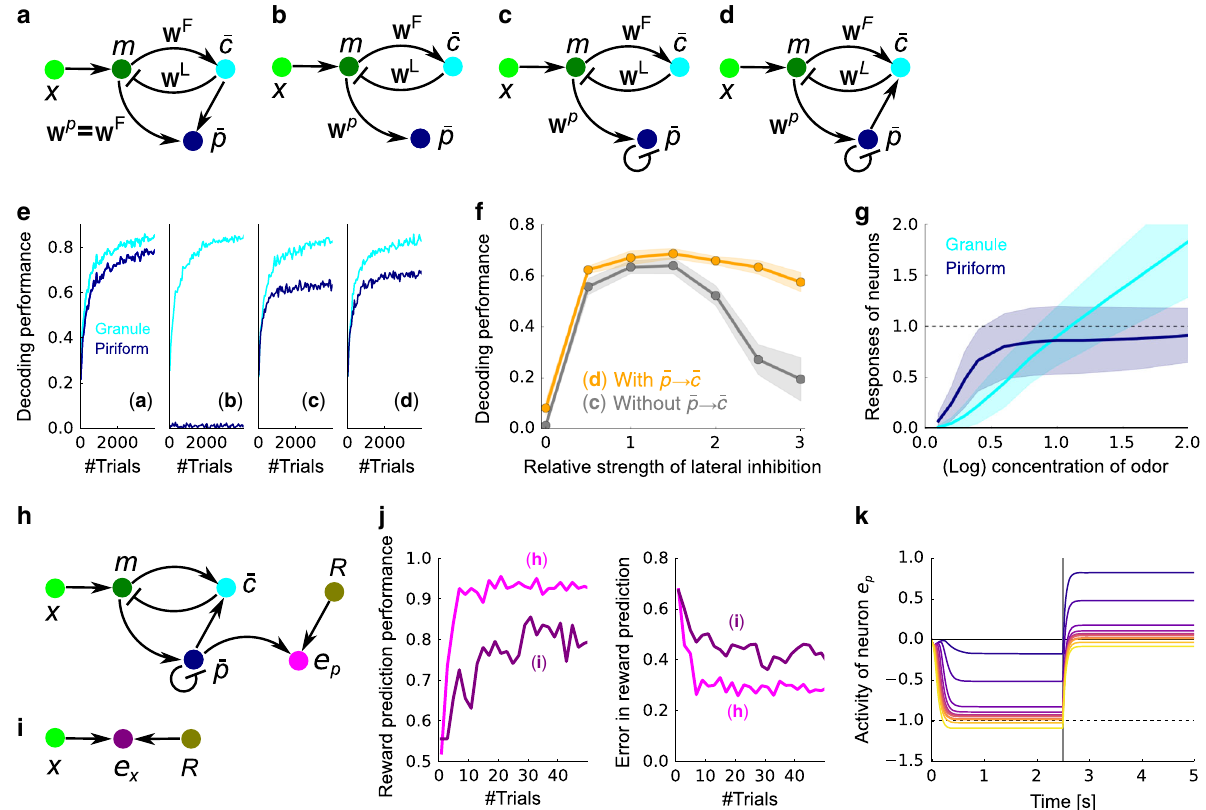
Fig. 7 Learning a concentration invariant representation and an odor-reward association. a – d A set of increasingly realistic decoding models. a The decoding model associated with our variational Bayesian inference algorithm. Note that the weights need to be copied from w F to w p , something that is not biologically plausible. b Similar circuit, but with the mapping from m to p learned via a local rule. c Same as b , but with lateral inhibition. d Same as c , but with feedback to the granule cells. e Learning performance for the models in a – d when decoding from granule cells (cyan) or piriform cortex (dark blue; see subsection “ Odor estimation performance ” in the “ Methods ” section). f Comparison of performance for model c (gray) and d (orange). Mean and standard deviation over 10 simulations are plotted. g Mean and standard deviation of responses of the granule cells, (cid:1) c , and the piriform neurons, (cid:1) p , for their selective odors presented at various concentrations. The responses were measured by presenting each odor in isolation with different concentration, and then averaging over populations. h Schematic of the reward prediction circuit utilizing concentration-invariant representation in the piriform cells, (cid:1) p . i Direct reward prediction from neural activity at glomeruli. j Performance of odor – reward association measured by the classi fi cation performance (left) and the mean-squared error between the predicted reward and the actual reward (right) for the models in panels h (magenta) and i (purple). Lines are mean over 100 simulations. k The mean response of neuron e p given an odor associated with the reward. The vertical line at τ = 2.5 s represents the reward presentation, and the dotted horizontal line is the sign- fl ipped reward value ( − R ). Different colors represents the different concentrations of the presented odor, from purple ( c ≈ 0.1) to yellow ( c ≈ 2.0). In all panels, M = 50 odors, N = 200 glomeruli, and three odors were presented on average, except for the go/no go task where one of two selected odors was presented